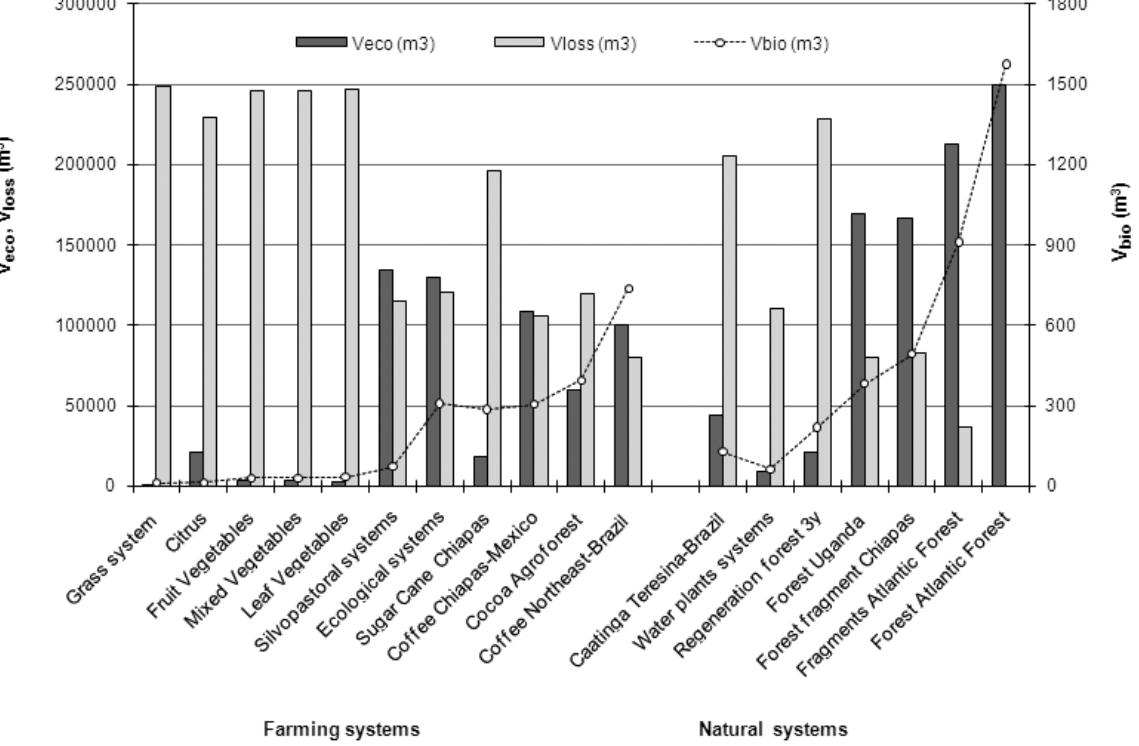
Fig. 2 – Eco-volume (V eco ), bio-volume (V bio ) and volume-loss (V loss ) of agricultural and natural